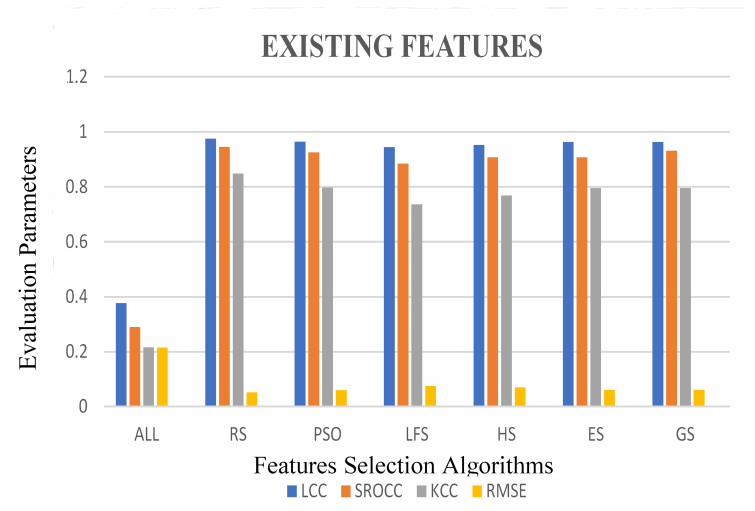
Figure 3. The performance comparison of feature selection algorithms in terms of LCC, SROCC, KCC, and RMSE scores.